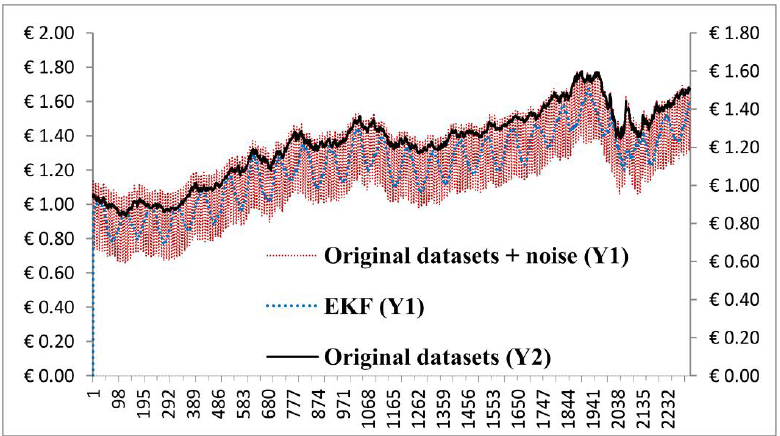
Figure 9. Plots of the original datasets, original datasets + noise, and the EKF